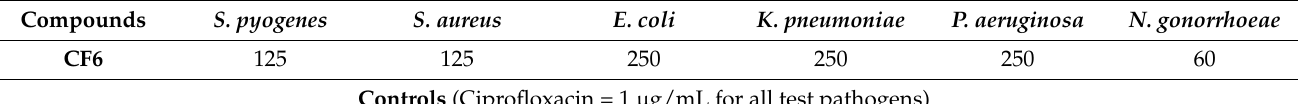
Table 2. Minimum inhibitory concentration (MIC in µ g/mL) for the isolated compounds against six pathogens. Compounds